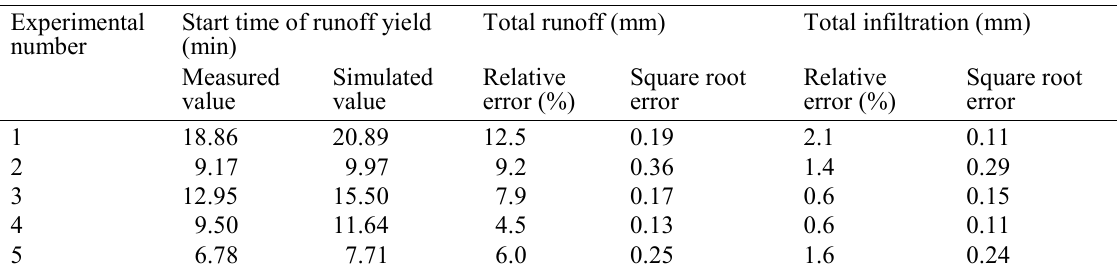
Table 3 Statistical analysis on simulated and measured values of rainfall infiltration and runoff. Experimental